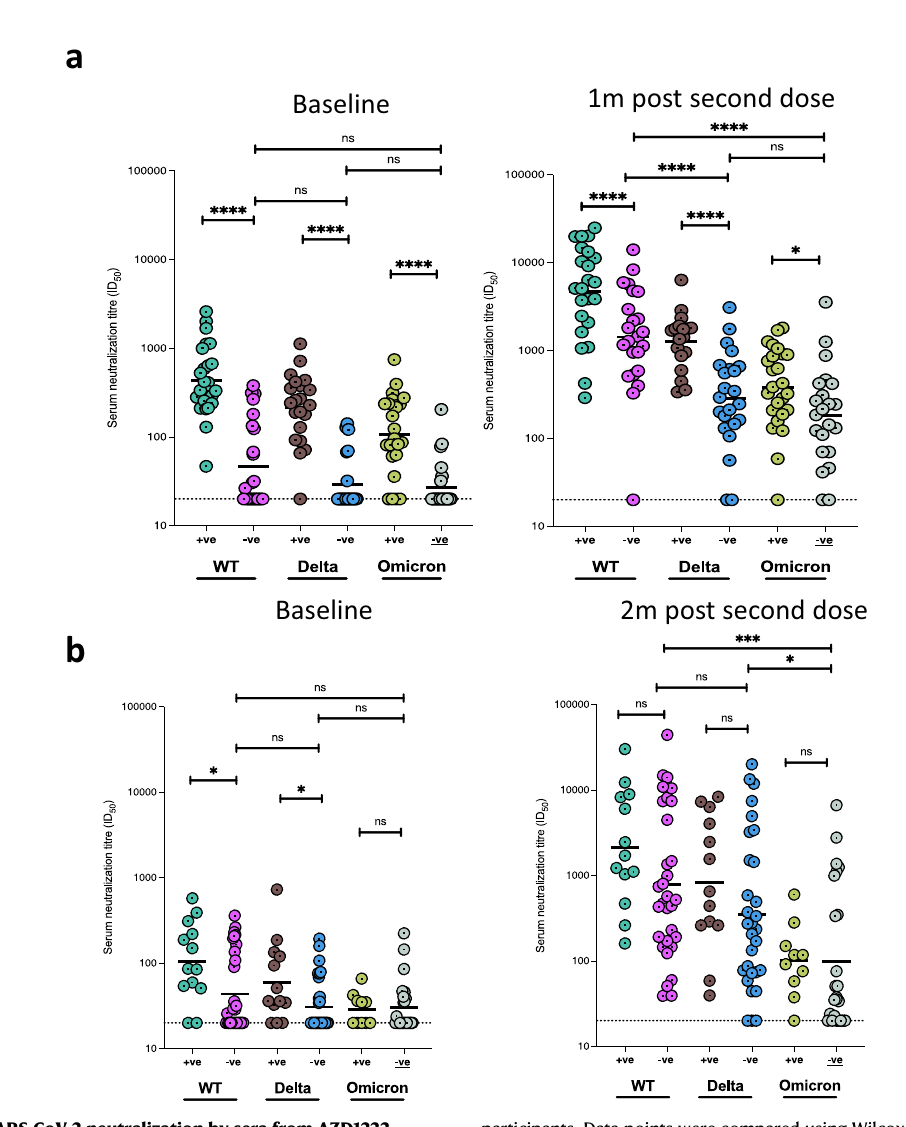
Fig. 2 | Longitudinal SARS-CoV-2 neutralization by sera from AZD1222 vacci- nated individuals in two west African countries. a Plasma neutralization of pseudovirus after two doses of the AZD1222 from Nigerian participants at three consecutive time points: baseline (prior to fi rst-dose vaccination), 1mth after 2 nd dose vaccination and 3mth after vaccination ( n =49). b Plasma neutralization of pseudovirus after two doses of the AZD1222 from Ghanaian participants at two consecutive time points: baseline (prior to fi rst-dose vaccination) and 1mth after 2nd dose vaccination ( n =45). Data are representative of two independent experi- ments comprising of two technical replicates. c Plasma neutralization of pseudo- typed virus after two doses of the AZD1222 vaccine against VOC from ( n =15)